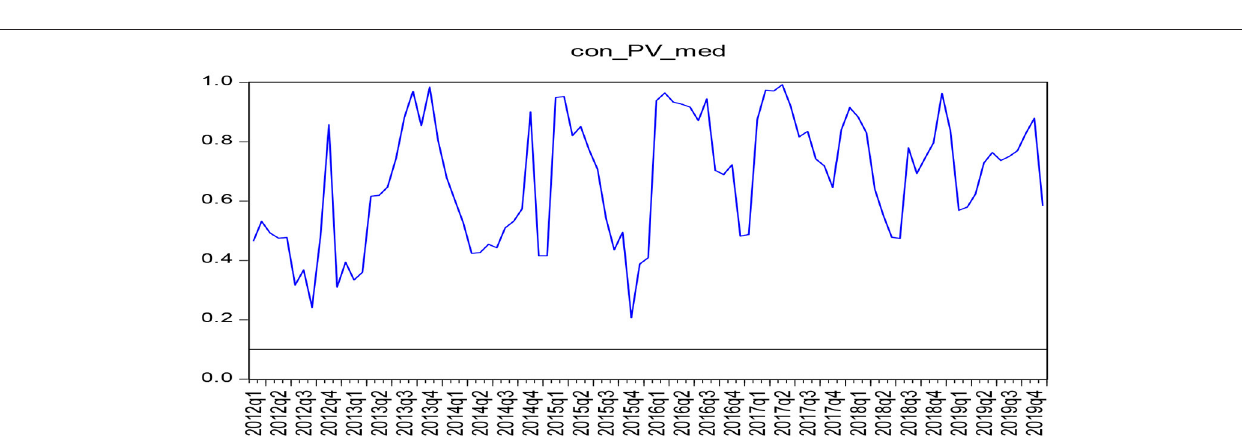
FIGURE 2 | P -value diagram of the causality test of shoe rolling sample (consumer expenditure - medical